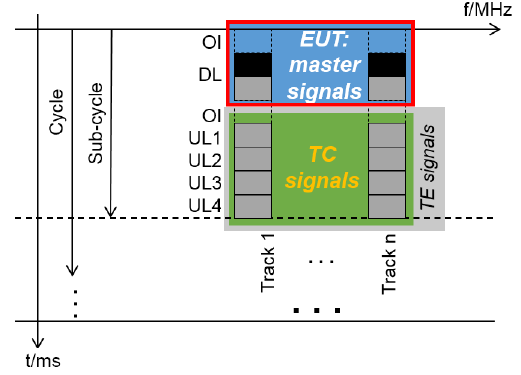
Figure 11. A master as EUT: DL and UL signals for master